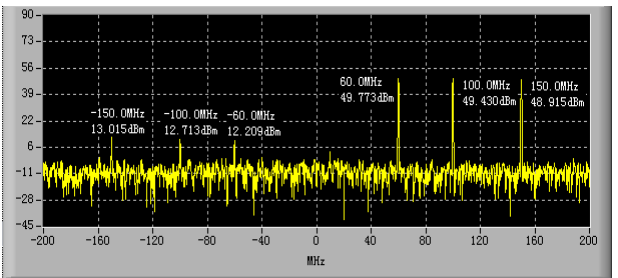
Figure 10. Frequency spectrum of the three-tone signal before LPI compensation.